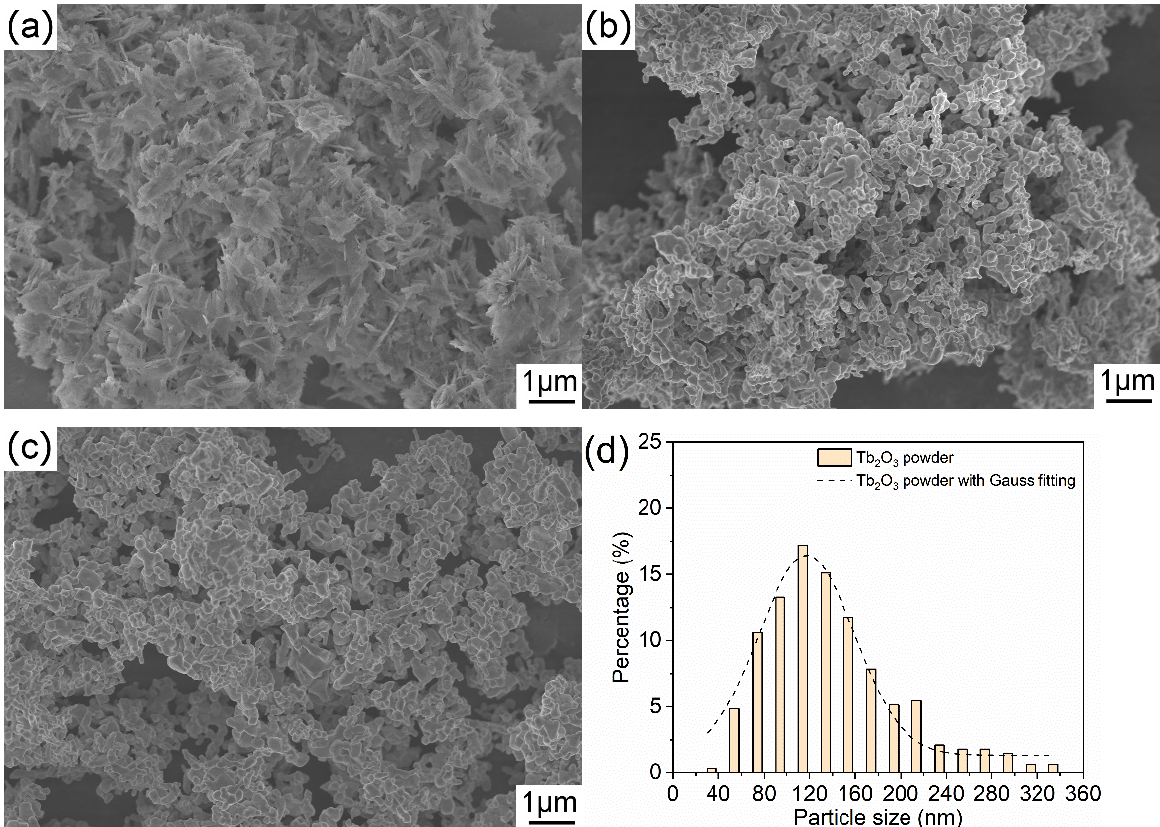
Figure 4. FESEM images of the precursor ( a ), the air calcined powder ( b ), the Tb 2 O 3 powder ( c ), and the particle size distribution histogram of the Tb 2 O 3 powder ( d ).